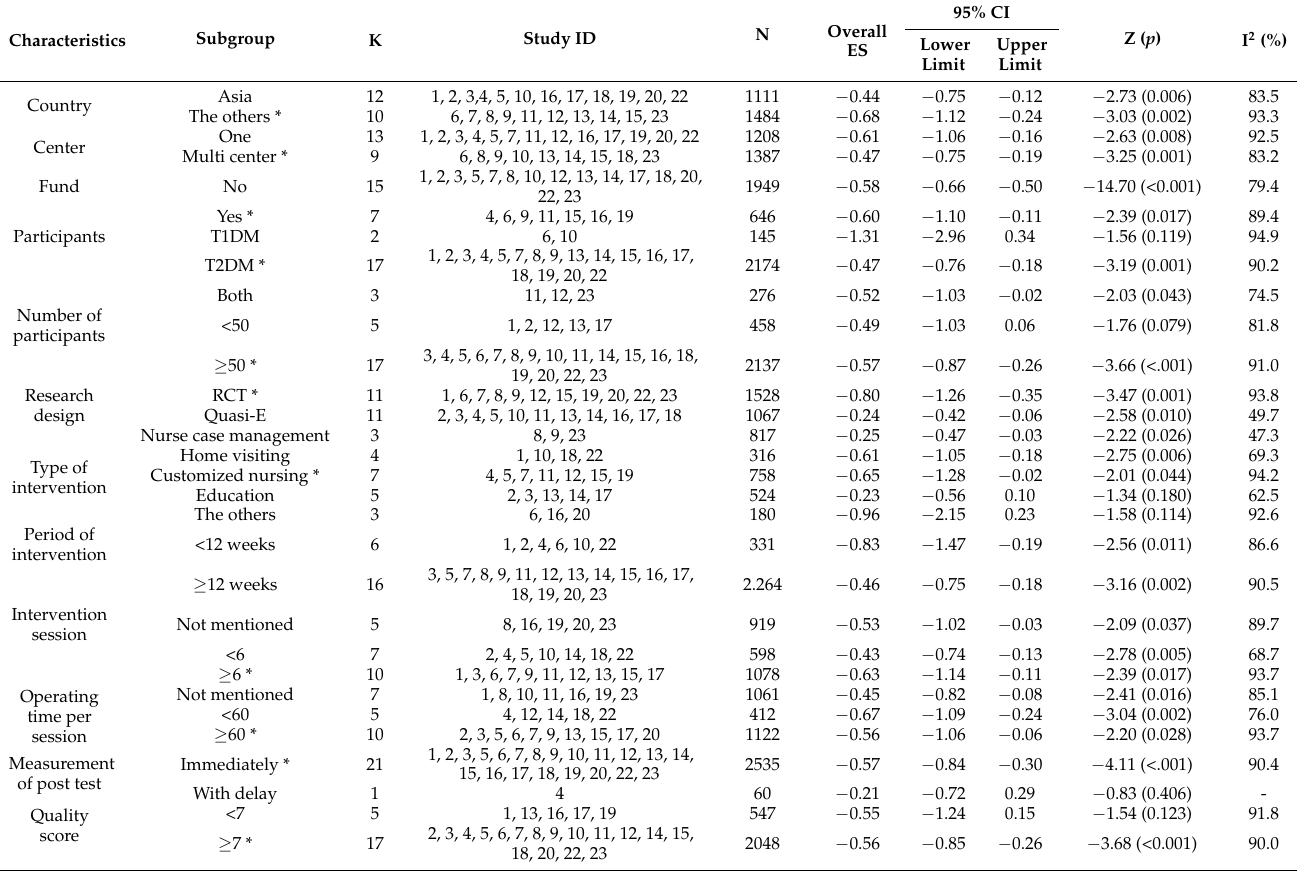
Table 4. The subgroup analysis by the study characteristics on